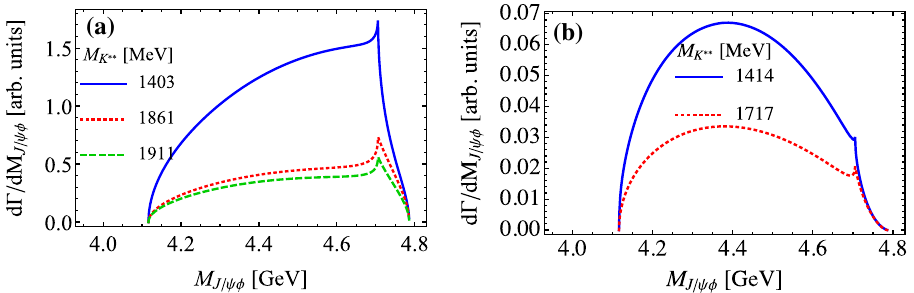
K ( 1911 ) (dashed line) given by LHCb [1], separately. For b : The mass and width of K ∗∗ with J P = 1 − are taken to be those of K ∗ ( 1410 ) (solid line), and K ∗ ( 1680 ) (dotted line) given by LHCb [1], separately